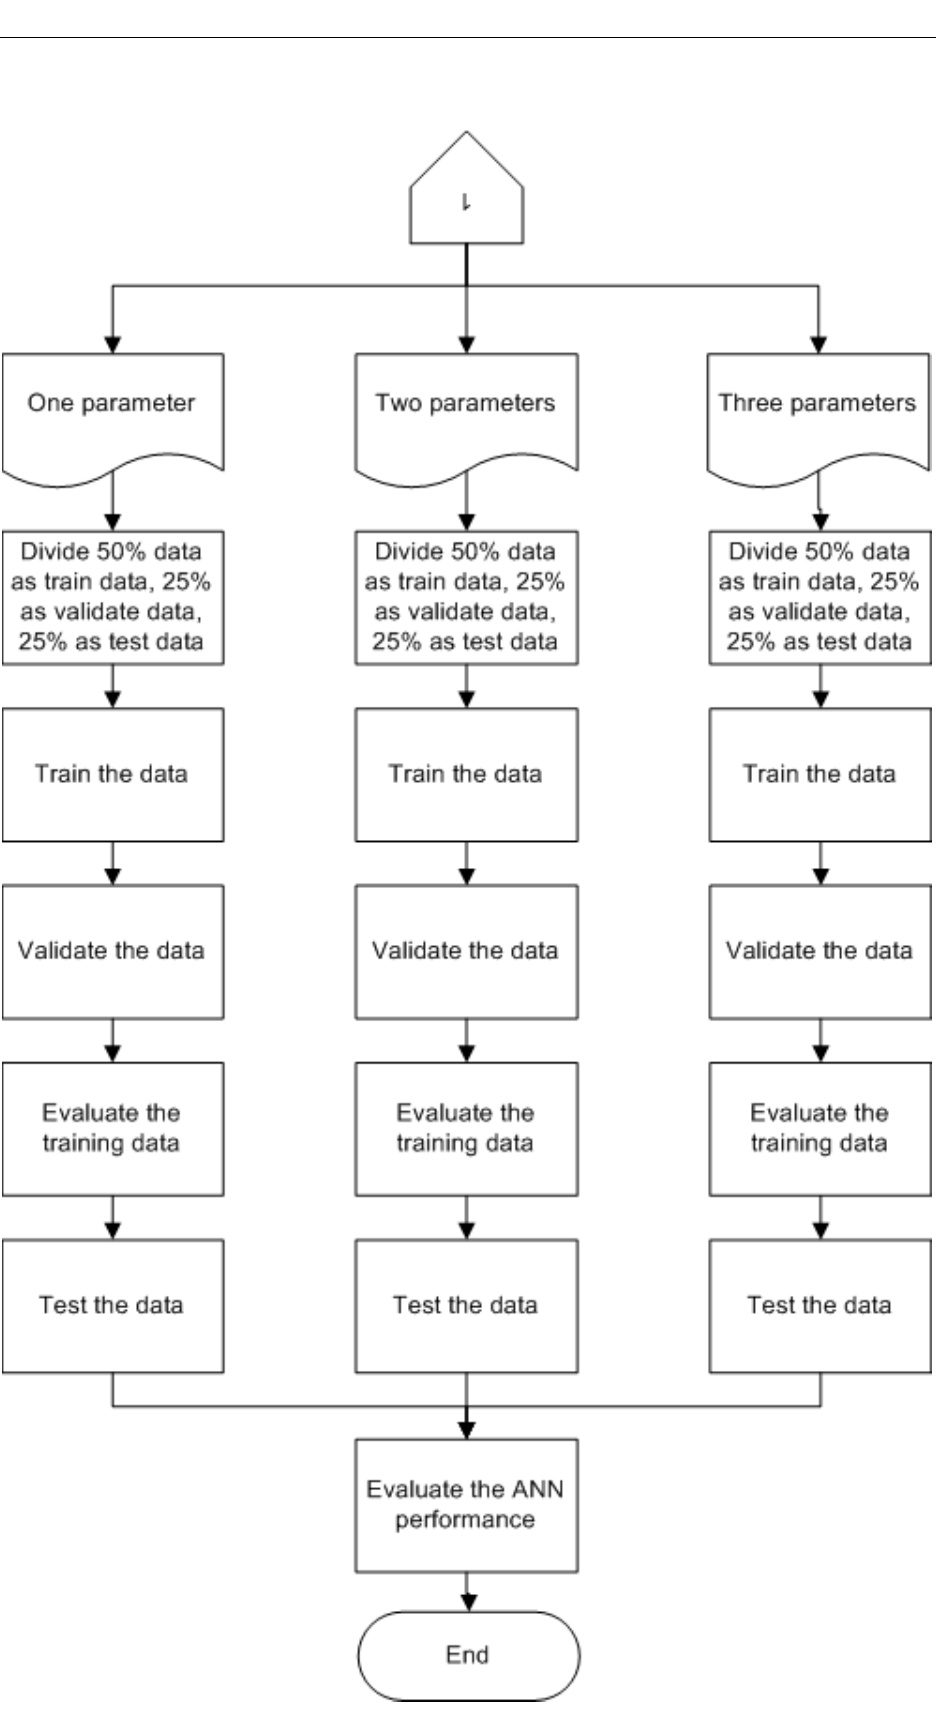
Figure 1. Flowchart of the research method. Table 1. Actual operation data used.